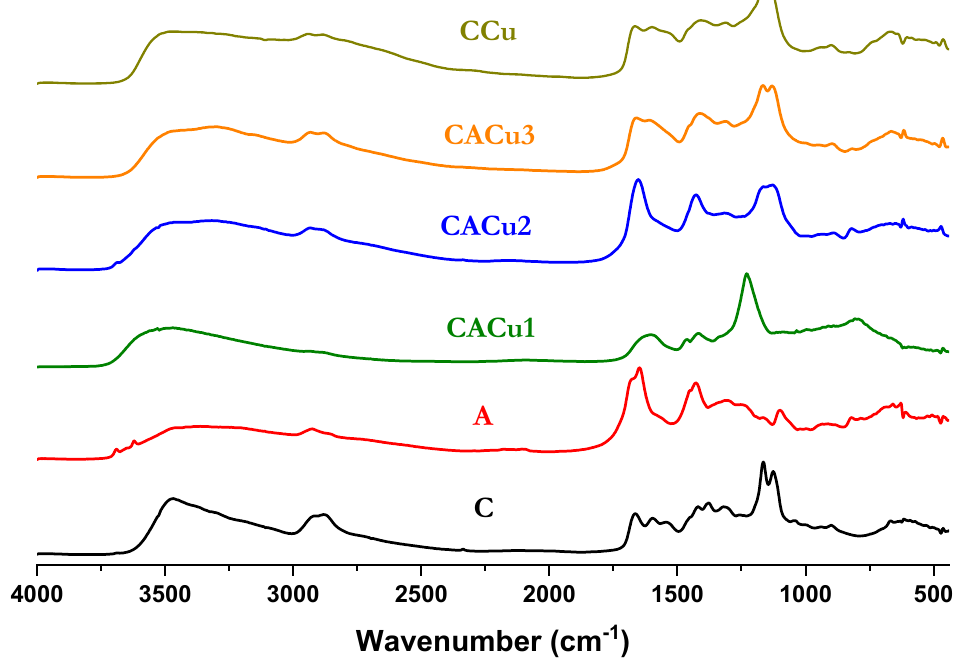
Figure 1. FTIR spectra of chitosan (C) and alginate (A) biopolymers, and its composite forms: CACu1, CACu2, CACu3 (ternary) and CCu (binary) materials.